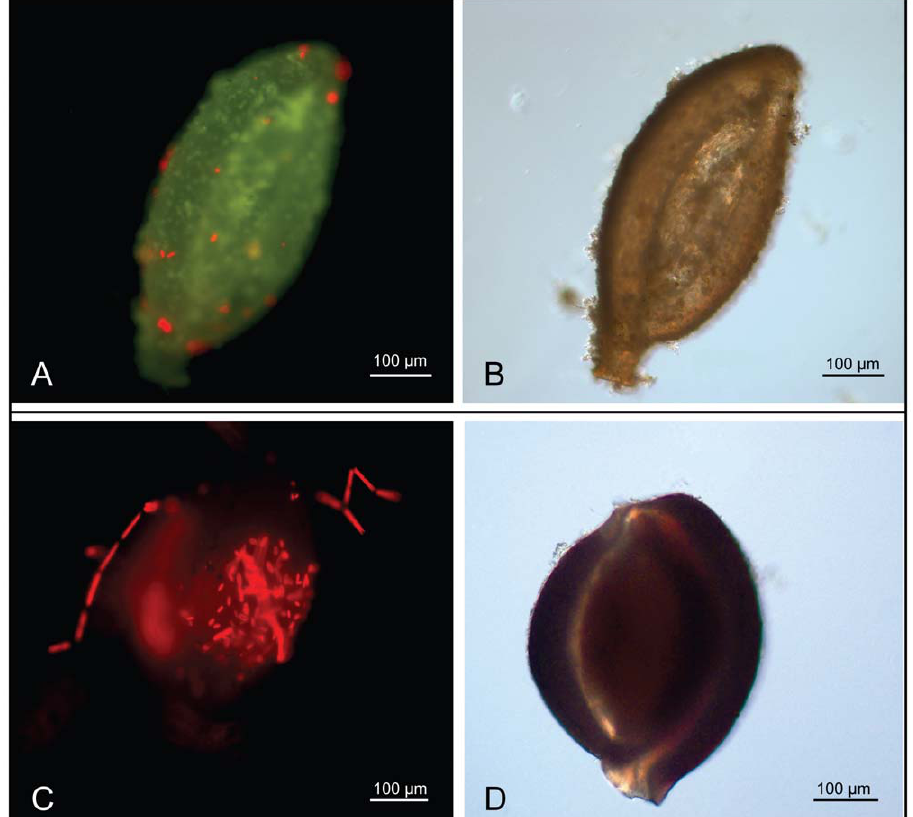
Figure 4. Exemplary microscopic images of Quinqueloculina (A, B) and Miliola (C, D) specimen profiled at 2151 m atm. (A, C) Chlorophyll autofluorescence (red) of phototrophic epiphytes on the calcite shell under green excitation light (FITC-filter